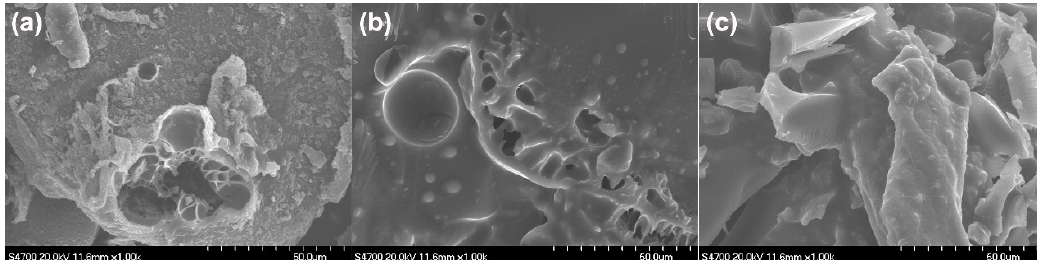
Figure 8. The SEM images of residues of flame-retardant PLA composites collected after the LOI test: C20 ( a ), A1C1M0 ( b ) and A2C1M1 ( c ). Figure 7. XPS spectra of the residues of the A2C1M1 sample after calcination in a muffle at 550 °C: C1s ( a ), O1s ( b ) and P2p ( c ). Table 3. EDX results of residues for flame-retardant PLA composites after LOI test.